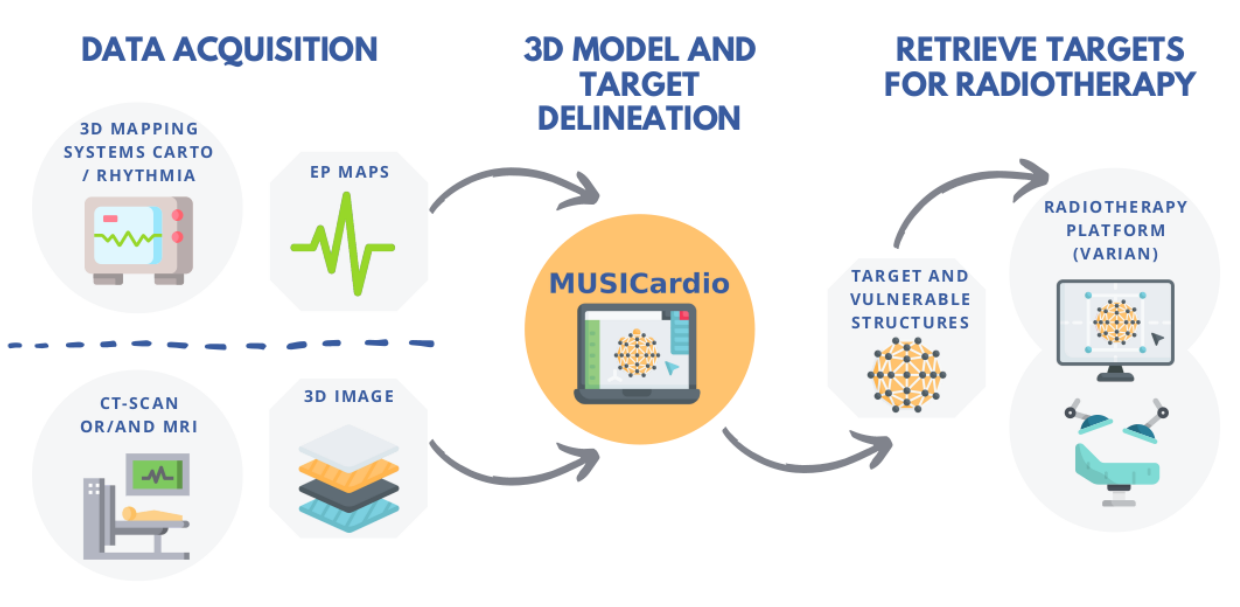
Figure 1. VT MUSIC consortium process (radiotherapy